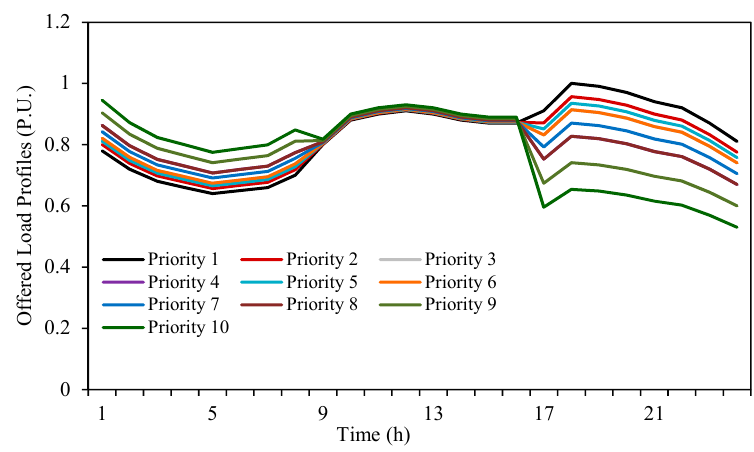
Figure 3. A typical customer’s set of ranked load profiles.